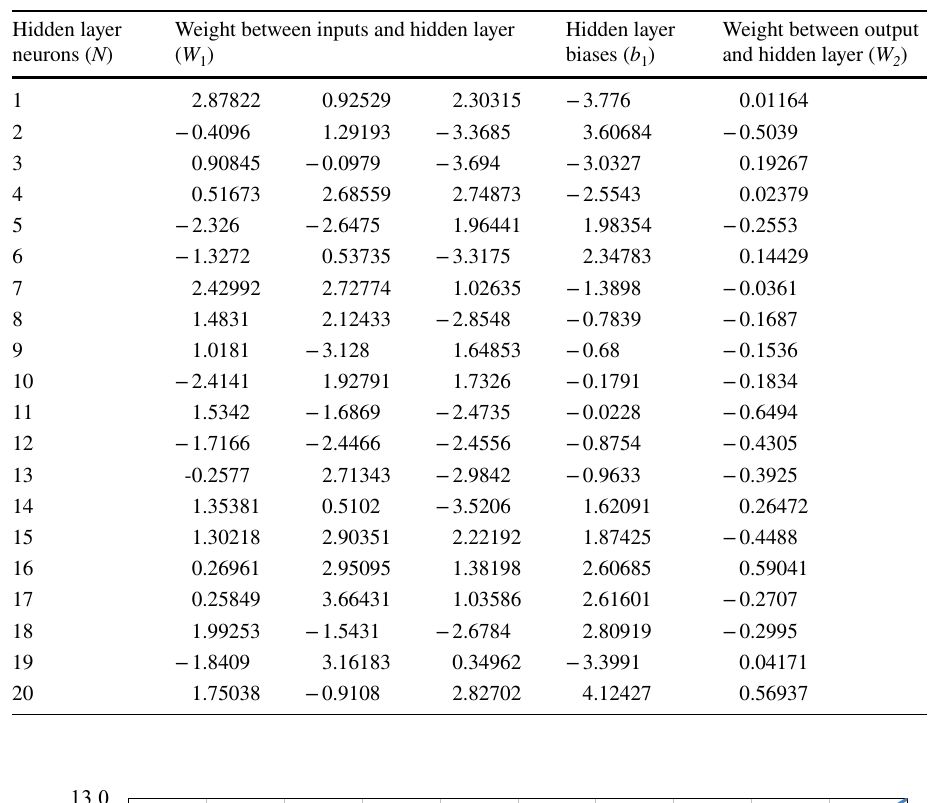
Fig. 10 Predicted ECD using empirical equation (Eq. 6) for the whole dataset (2376 data